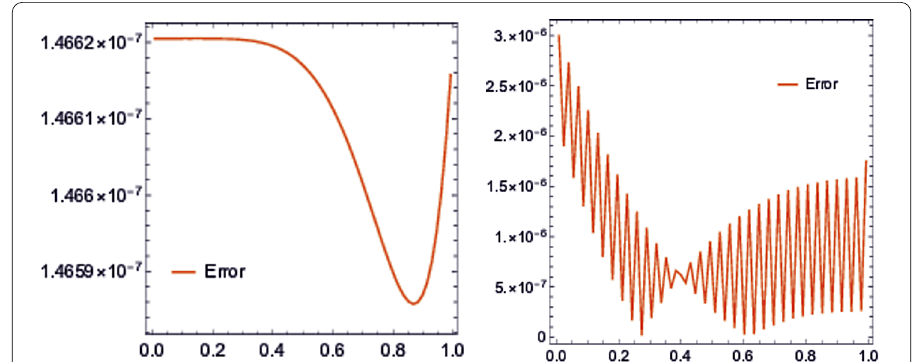
Figure 11 Error graphs of Example 4.4 for m = 3 and λ = 1.2 using framelet systems X ( (cid:7) 1 ) and X ( (cid:7) 2 ), respectively